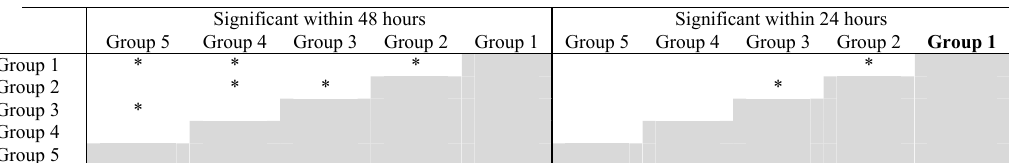
Table 4. Significance at concentration 0.75 at P<0.001 Table 4: Significance at concentration 0.75 at P<0.001